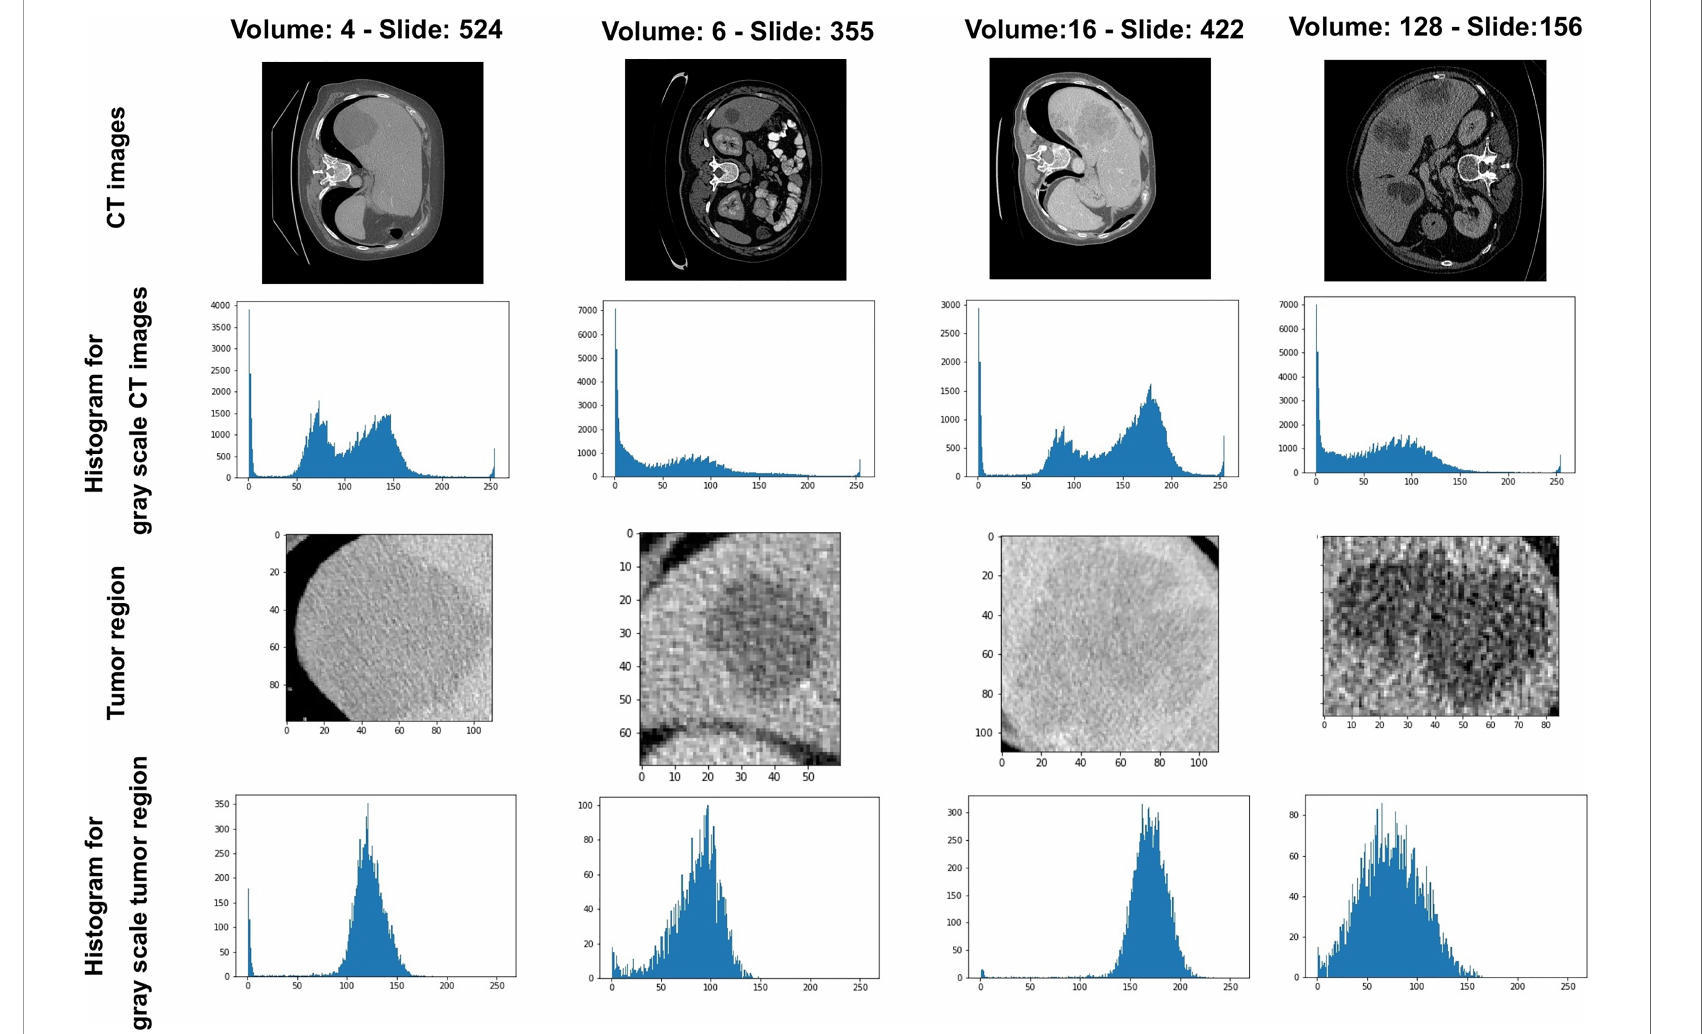
FIGURE 2 | Example of CT images and tumor regions with their histogram of gray-scale images,